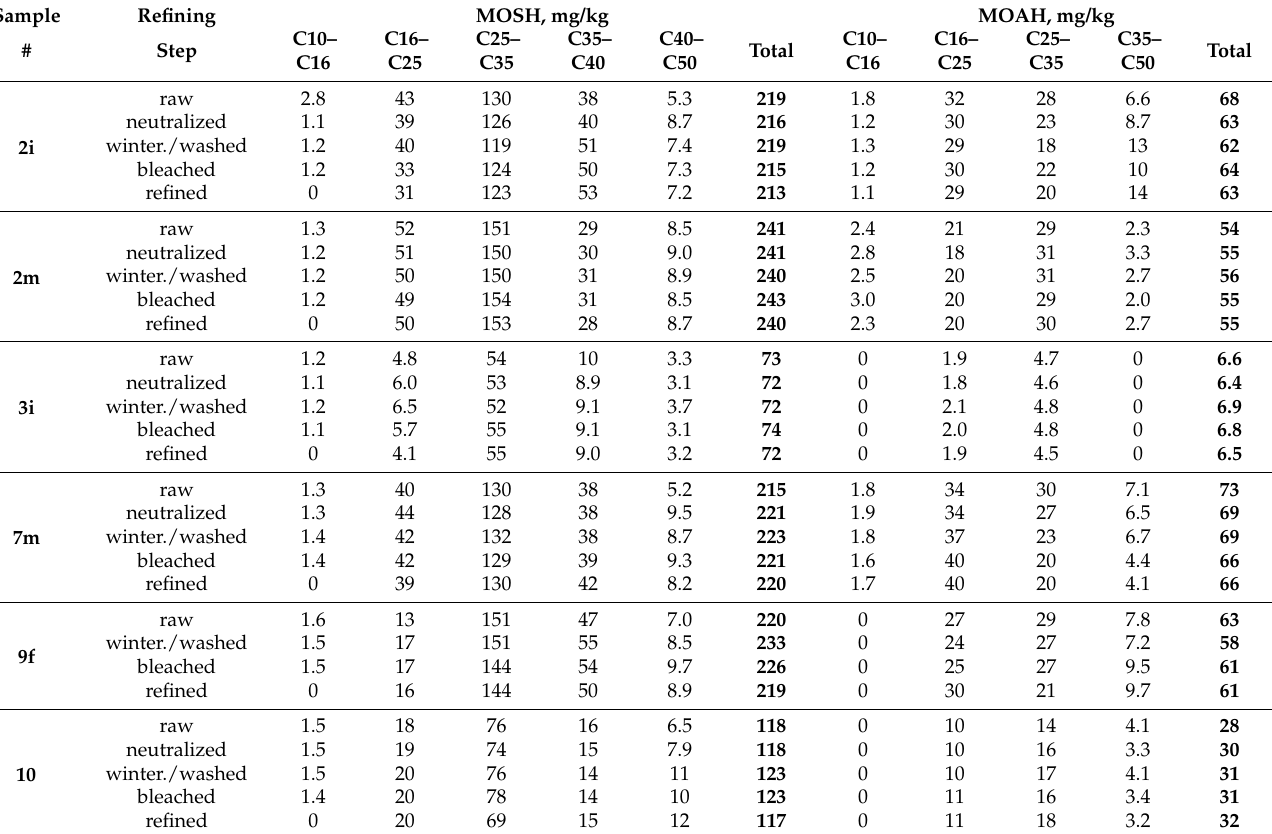
Table 2. Mineral oil saturated hydrocarbon (MOSH) and mineral oil aromatic hydrocarbon (MOAH) content in olive pomace oils sampled at different points of the chemical refining process. Results (in mg/kg and with two significant figures) are given for the C-fractions and for the sum of them. Notation (i, m, f) corresponds to that of Table